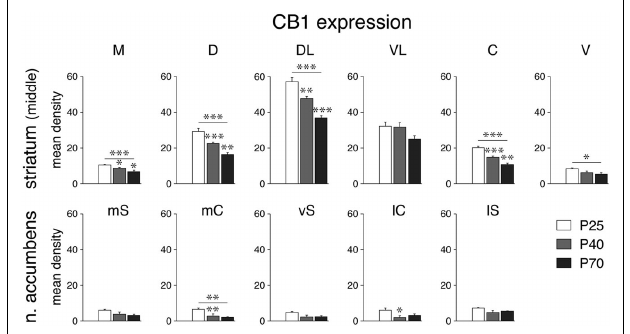
FIGURE 4 | Decrease in CB1 receptor expression during development in select striatal sectors. Mean density values (mean ± SEM) for CB1 expression at P25, P40 and P70 are given for the six sectors of the middle striatum (top) and the five sectors of the nucleus accumbens (bottom) (for abbreviations, see Figure 3 ). * P < 0.05, ** P < 0.01, *** P < 0.001, vs. preceding age group or as